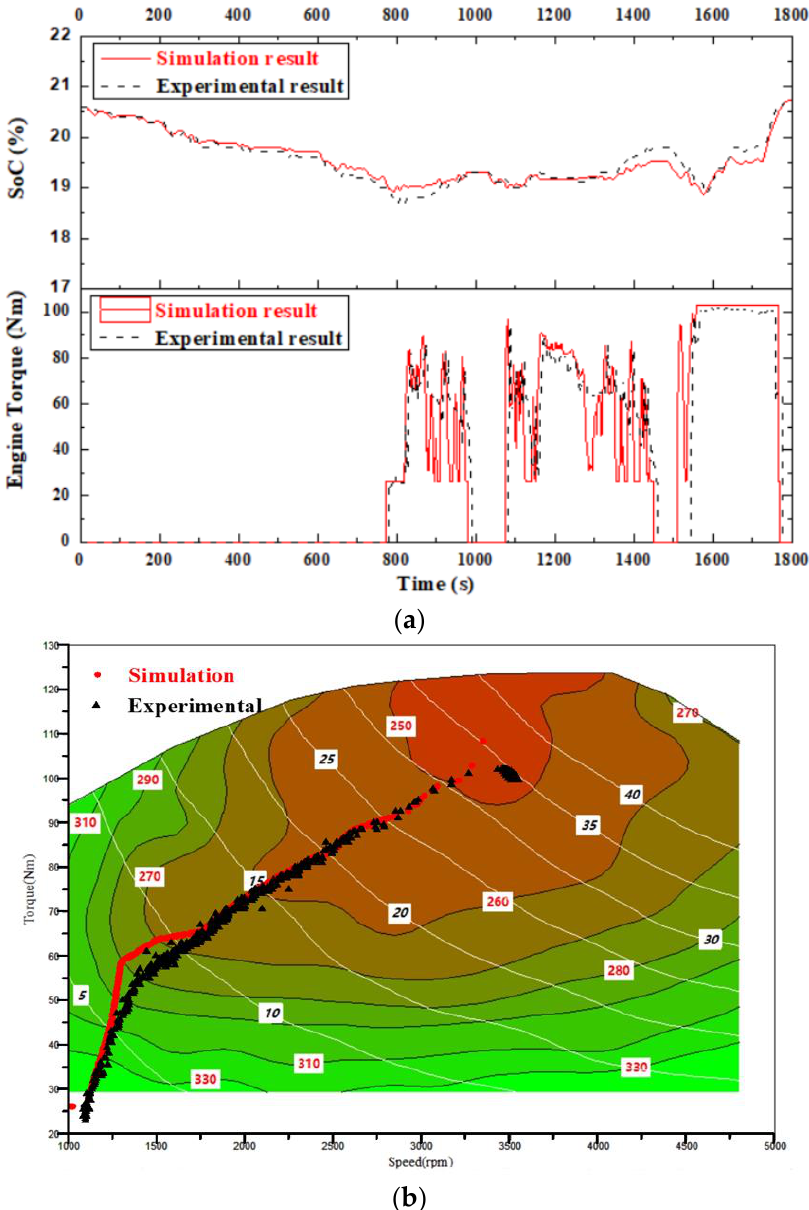
Figure 7. Comparison between simulation and experimental results for base EMS. ( a ) SoC and engine torque trajectory; ( b ) range extender operation points.